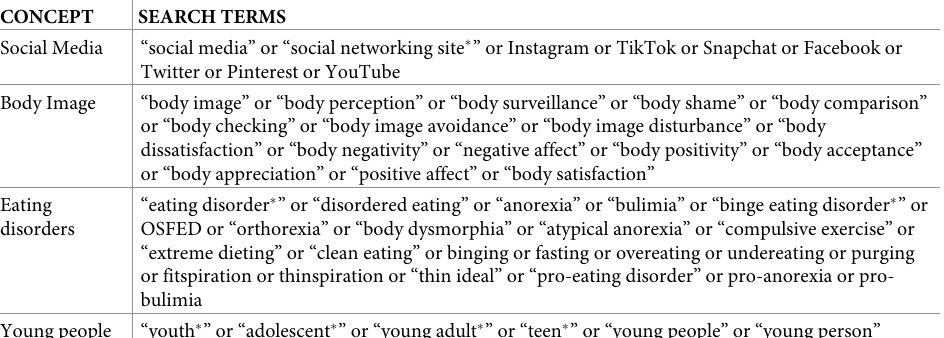
Table 4. Generic search